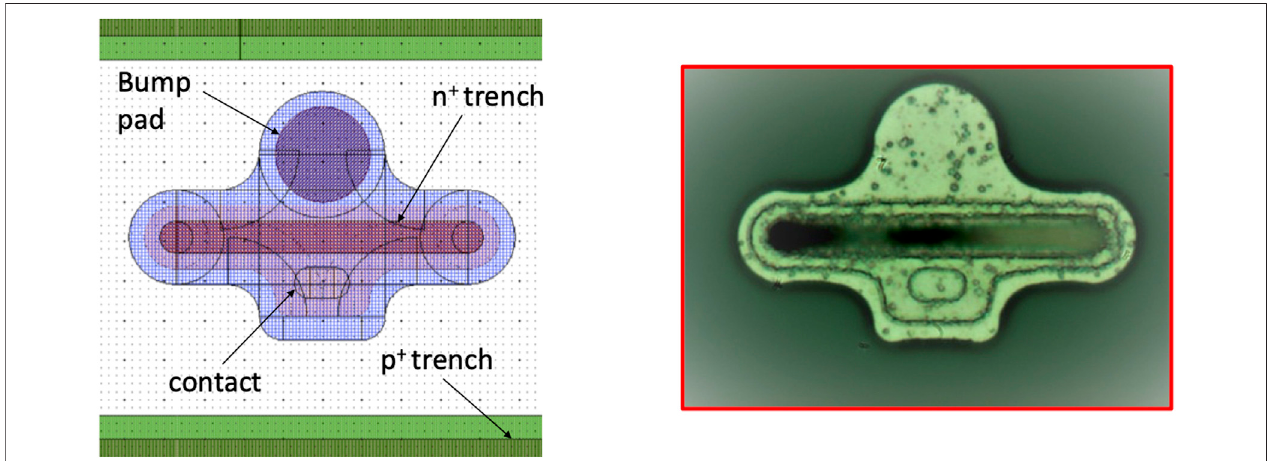
FIGURE 4 | Layout detail (left) and photograph (right) of a 3D pixel with trenched electrodes of 55 μ m × 55 μ m size.